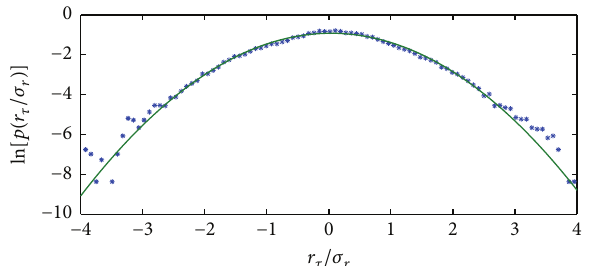
Figure 4: Empirical pdf of log return with 𝜏 = 32 ( ∗ -line), and theoretical distribution, Gaussian (solid